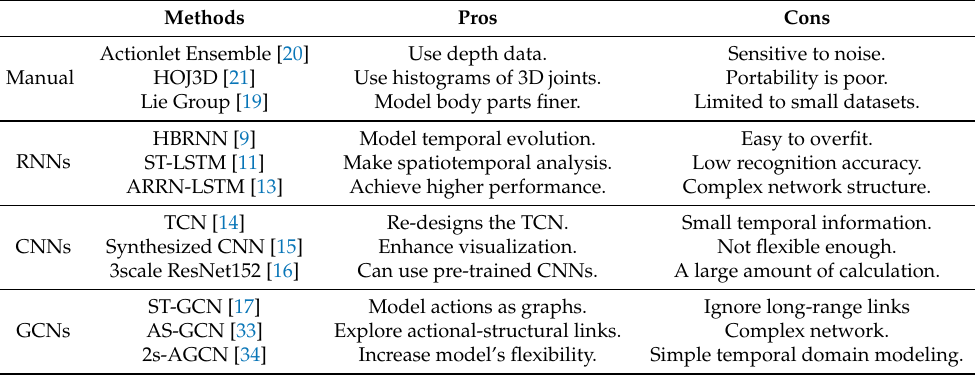
Table 1. Pros and cons of skeleton-based action recognition